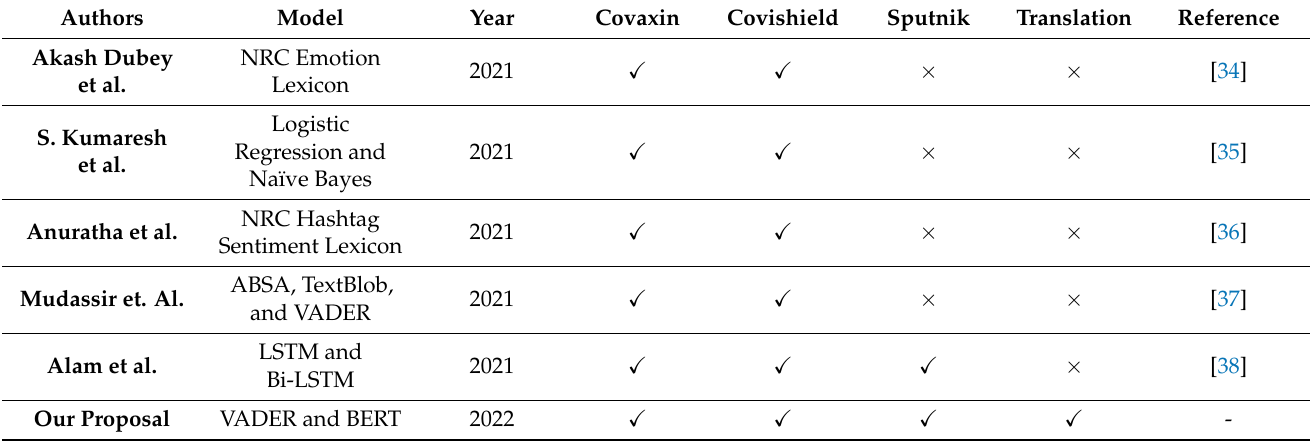
Table 1. Contribution of our work with respect to the related